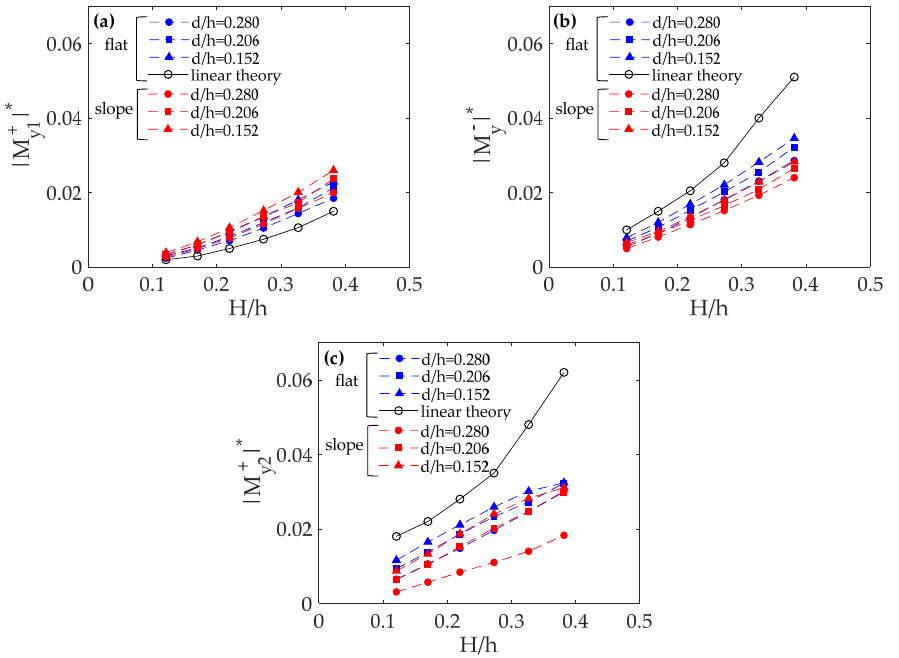
Figure 14. The overturning moments due to solitary waves in terms of the different wave force components ( a ) the first positive overturning moment, ( b ) the negative overturning moment and ( c ) the second overturning moment.